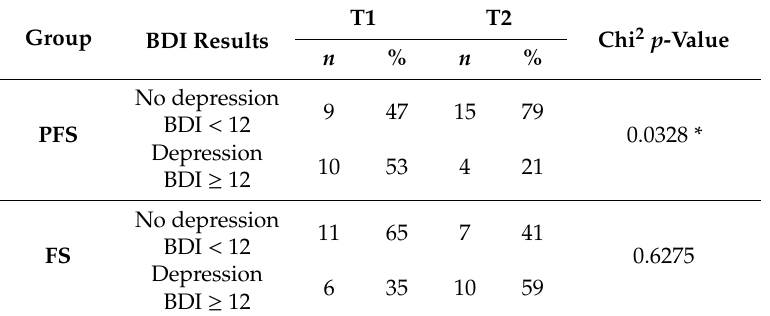
Table 2. Percentage distribution of Beck Depression Inventory (BDI) results in the study